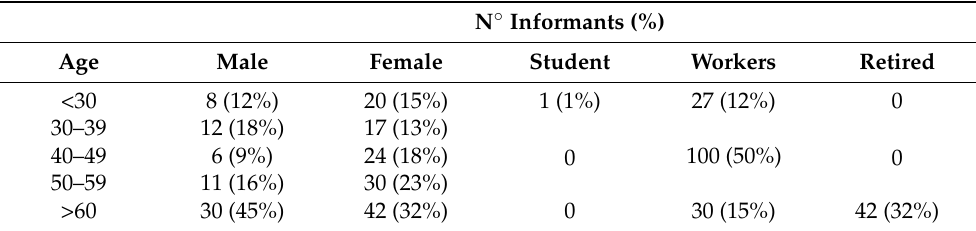
Table 2. Distribution of the 200 subjects interviewed in Trentino-South Tyrol based on age, sex, and